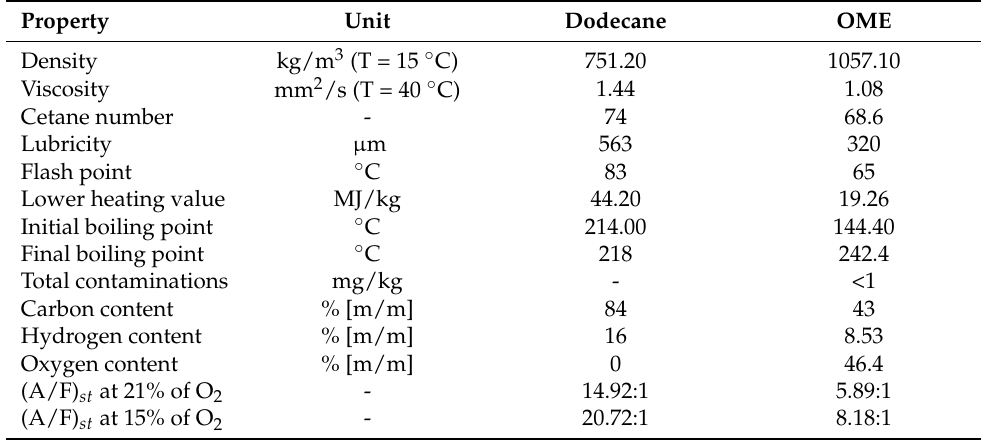
Table 2. Fuel properties for dodecane and